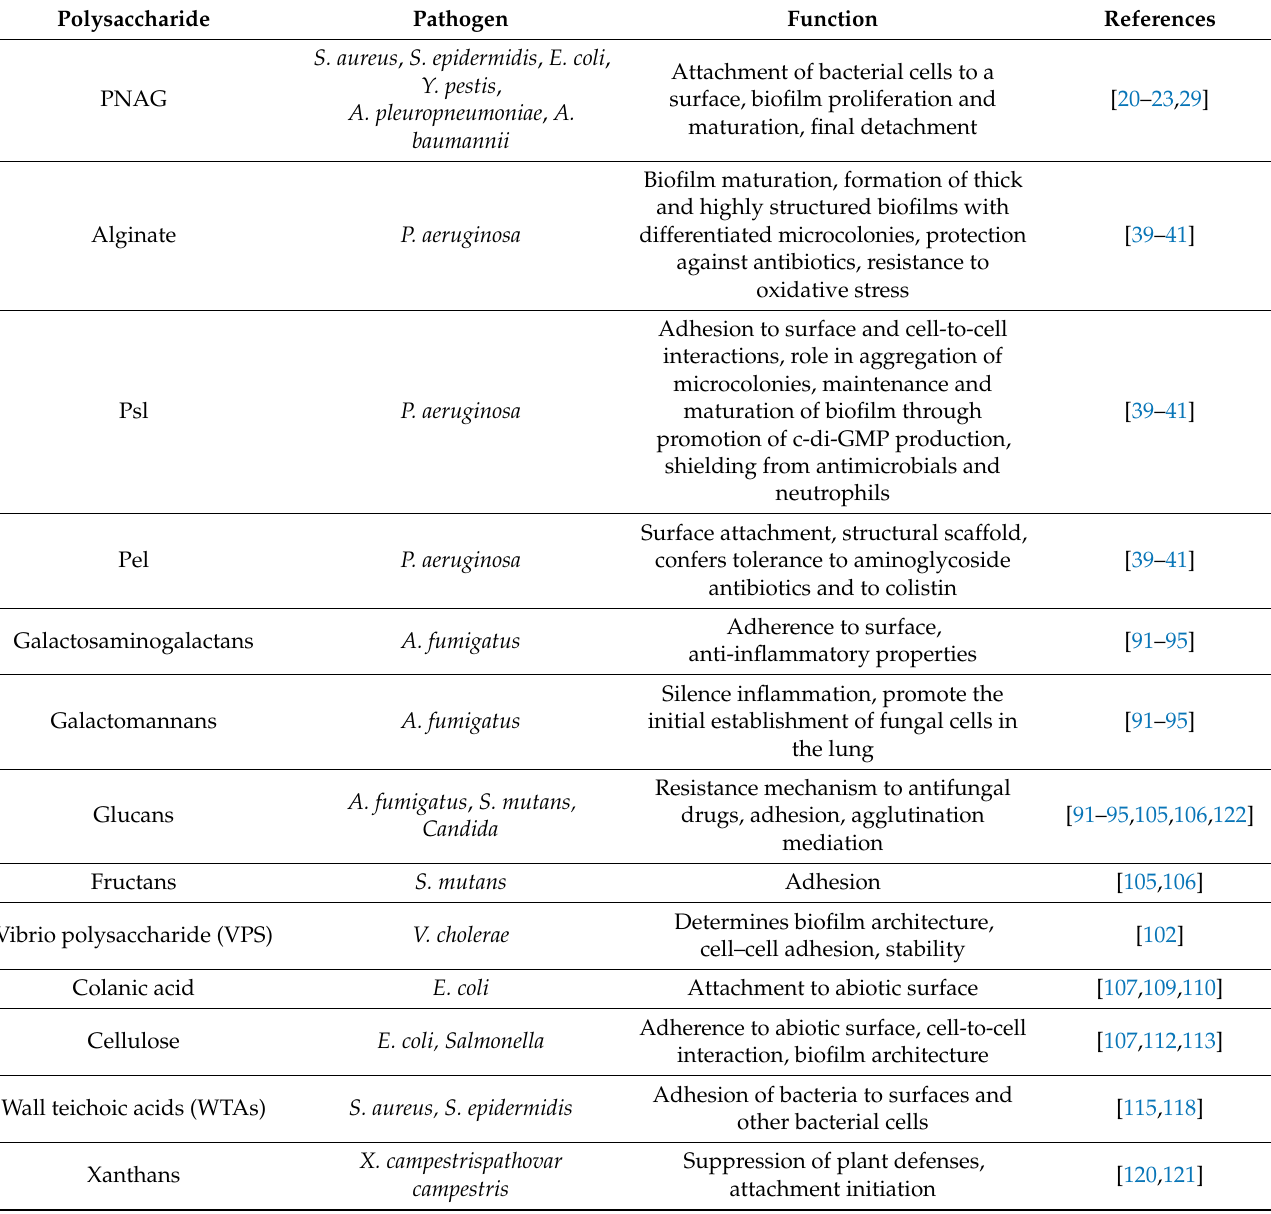
Table 1. Polysaccharides in biofilm and their